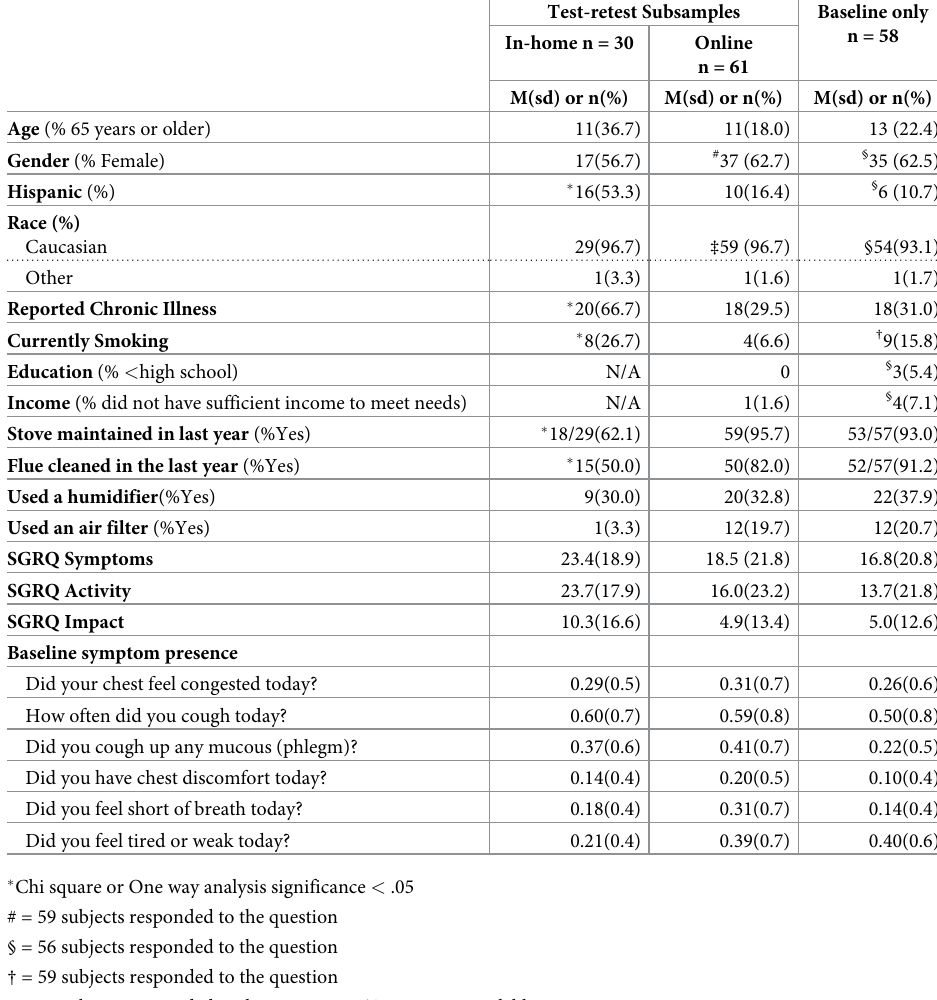
Table 2. Demographic characteristics of three enriched subsamples comprising the final sample of n =